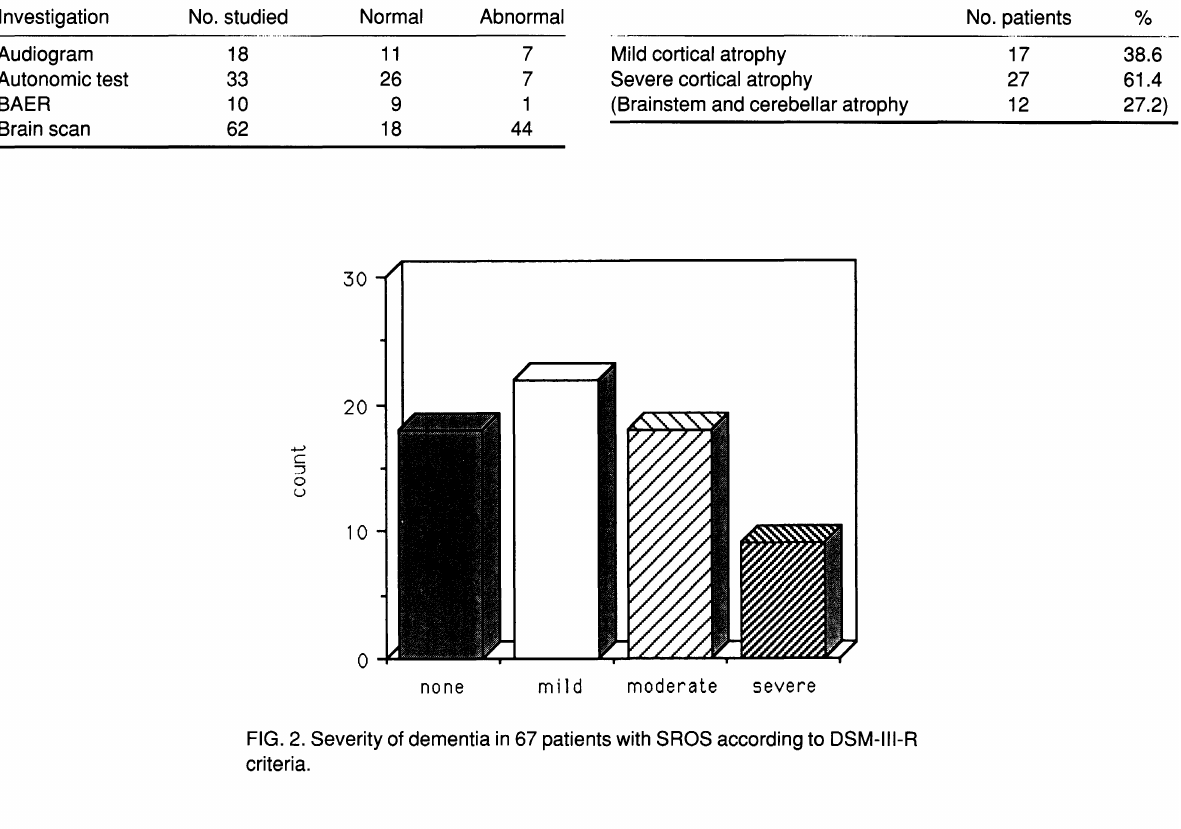
FIG. 2. Severity of dementia in 67 patients with SROS according to DSM-III-R